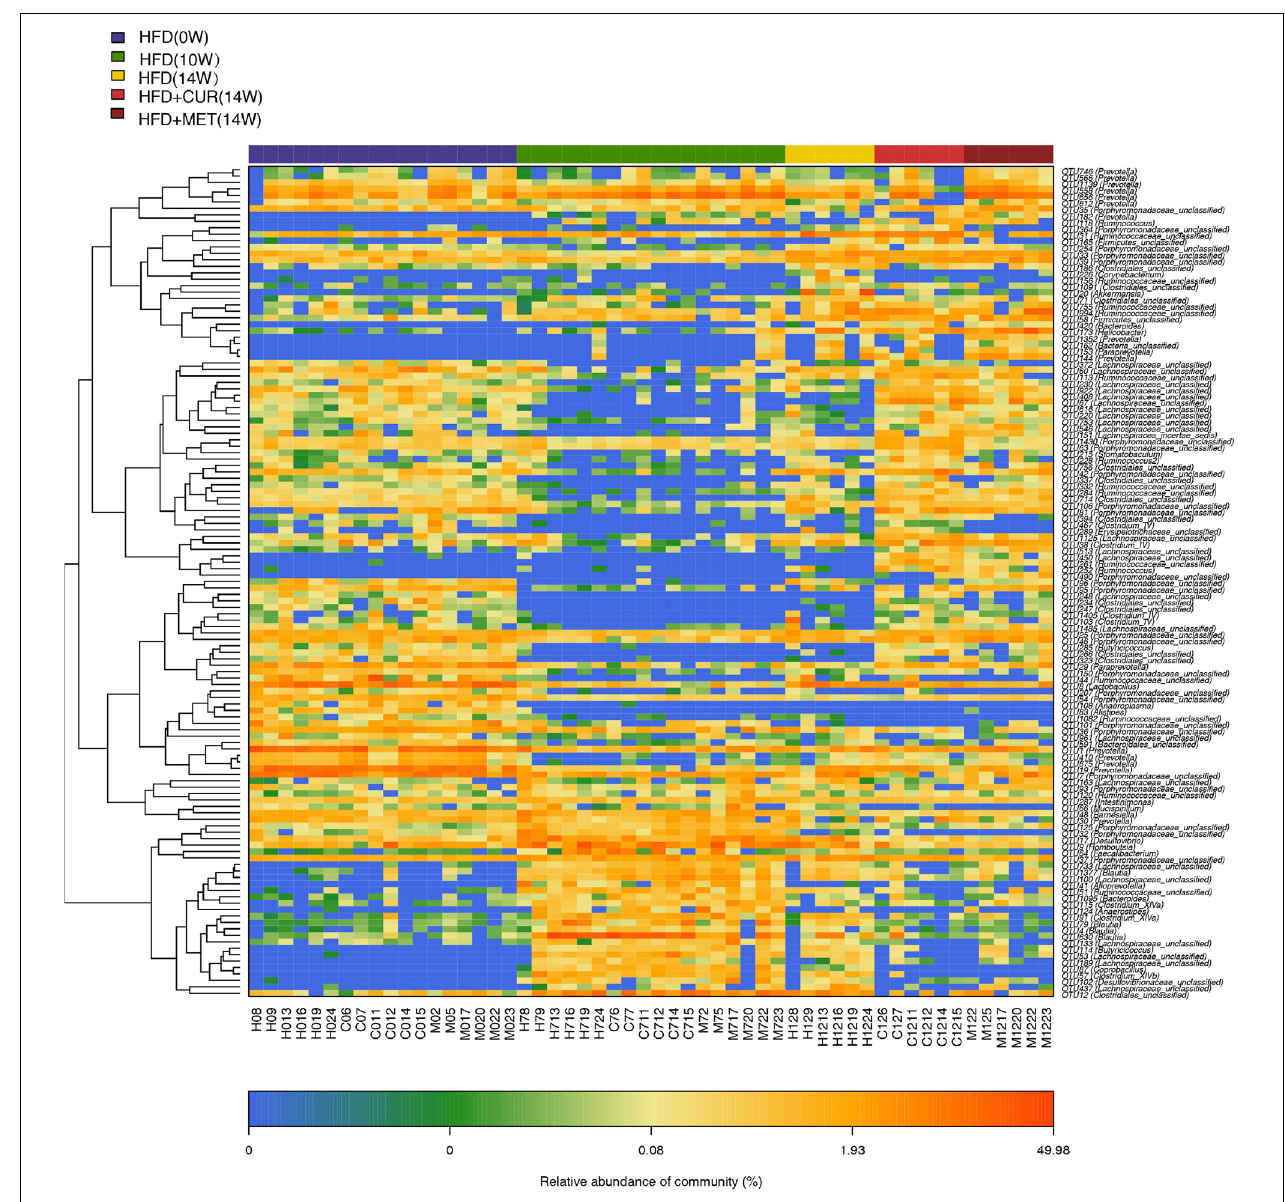
FIGURE 9 | Responses of the structure of the gut microbiota to HFD, CUR and MET treatment. Heatmap of the abundance of the OTUs in the HFD (0W), HFD (10W), HFD (14W), HFD + CUR (14W), and HFD + MET (14W) groups. Red and blue colors indicate the abundance of OTUs that were more and less